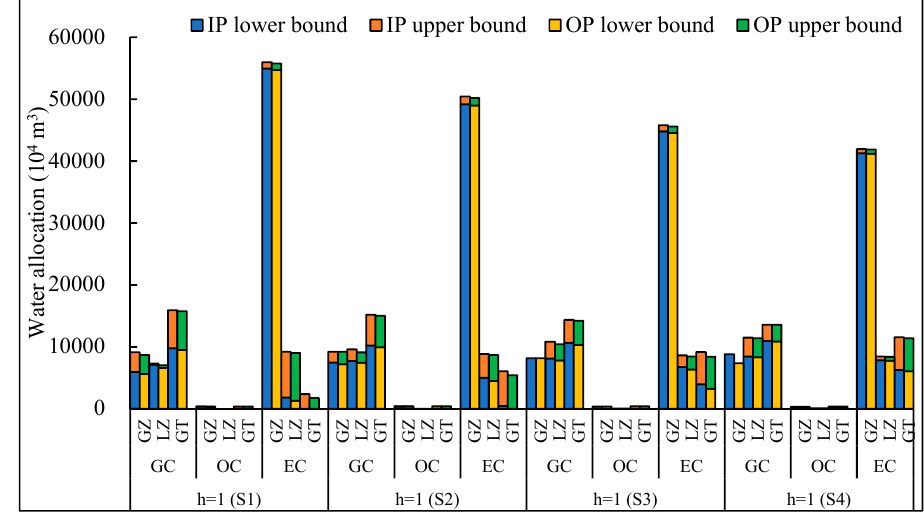
Figure 5. Economic benefits comparison based on the original plan (OP) and improved plan (IP) under different